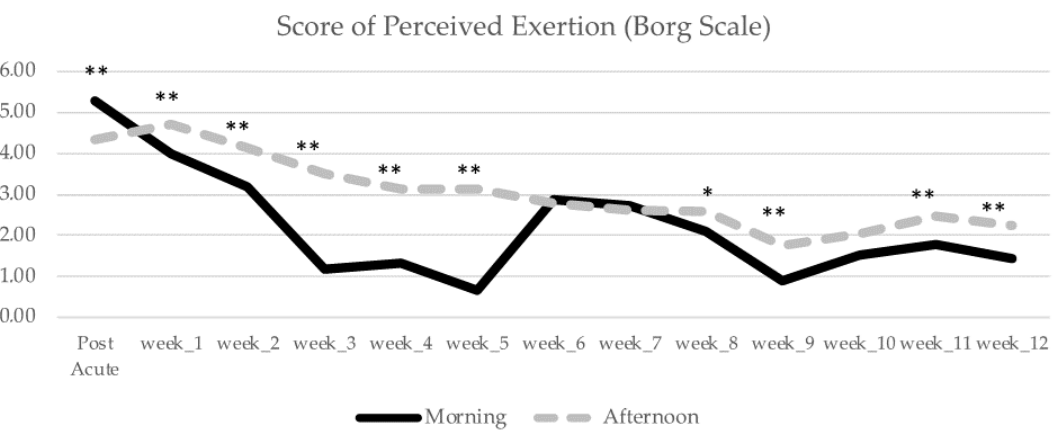
Figure 7. Score of perceived exertion across different time-points (post-Acute T1 and at the end of the last session of each week of the 12-week intervention program, including T2, the final session) for the M and A groups. * Indicates significant differences between M and A for p < 0.05; ** Indicate significant differences between M and A for p <